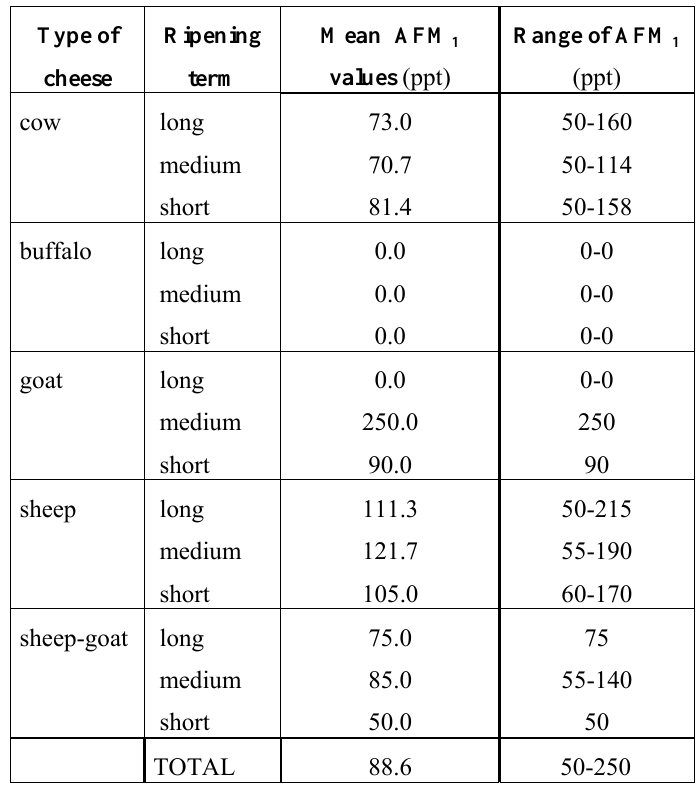
Table 2. Mean values and range of AFM at different terms of